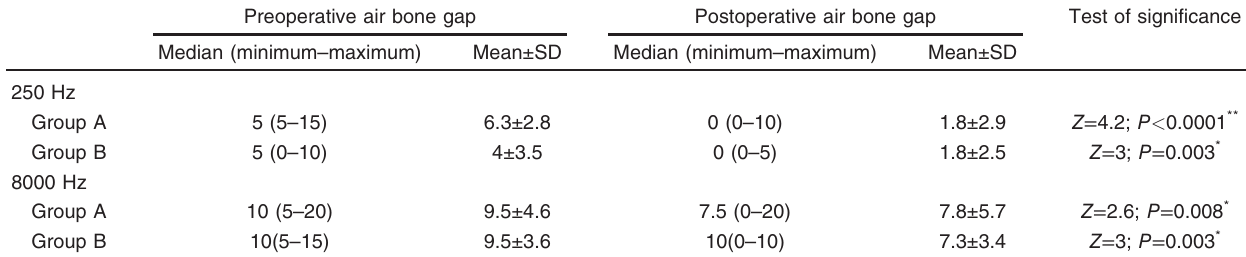
Table 2 Comparison between preoperative and postoperative air bone gap of group A and group B at 250 and 8000 Hz